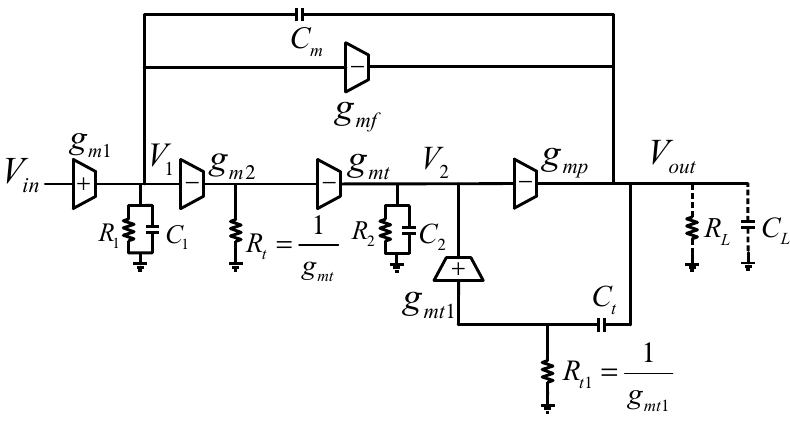
Figure 4. Simplified small − signal model of Figure 2.